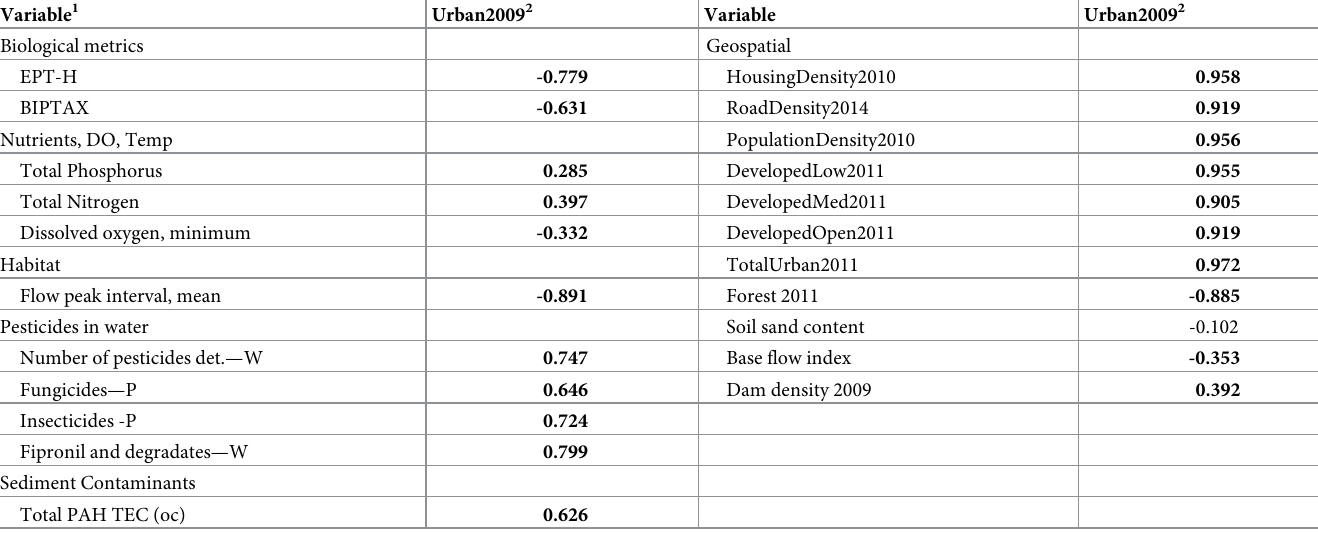
Table 1. Spearman’s rank correlation coefficients (rho) between Urban2009 and variables retained in BRT models of EPT-H and BIPTAX by Waite et al. (2019) (left columns) and geospatial metrics retained in BRT models presented herein (right